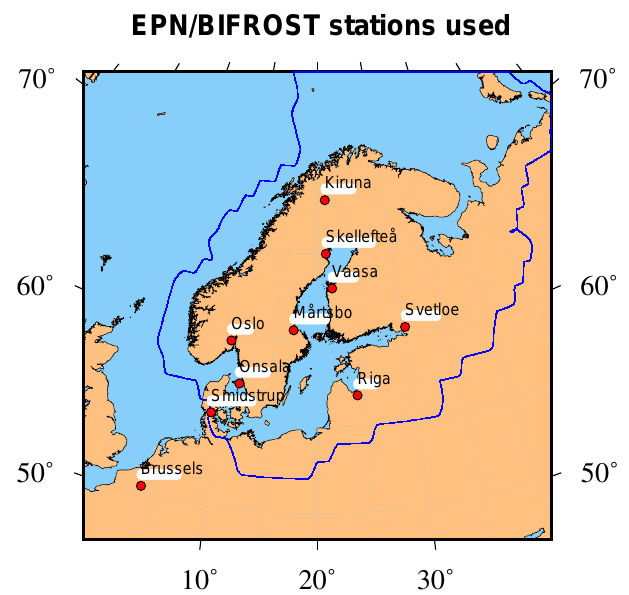
Figure 1. Location of EPN/BIFROST station used in our investiga- tion. The blue line marks the location of the ice margin at the Last Fig. 1. Overview of EPN/BIFROST station used in our investiga- Glacial tion.